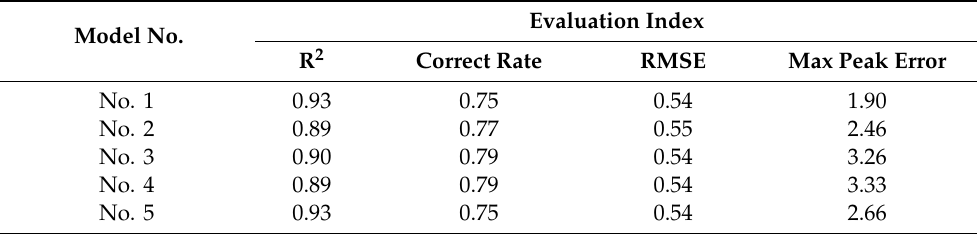
Table 10. Evaluation index value extracting only the data of each model where CRAC1 stopped. Model No.